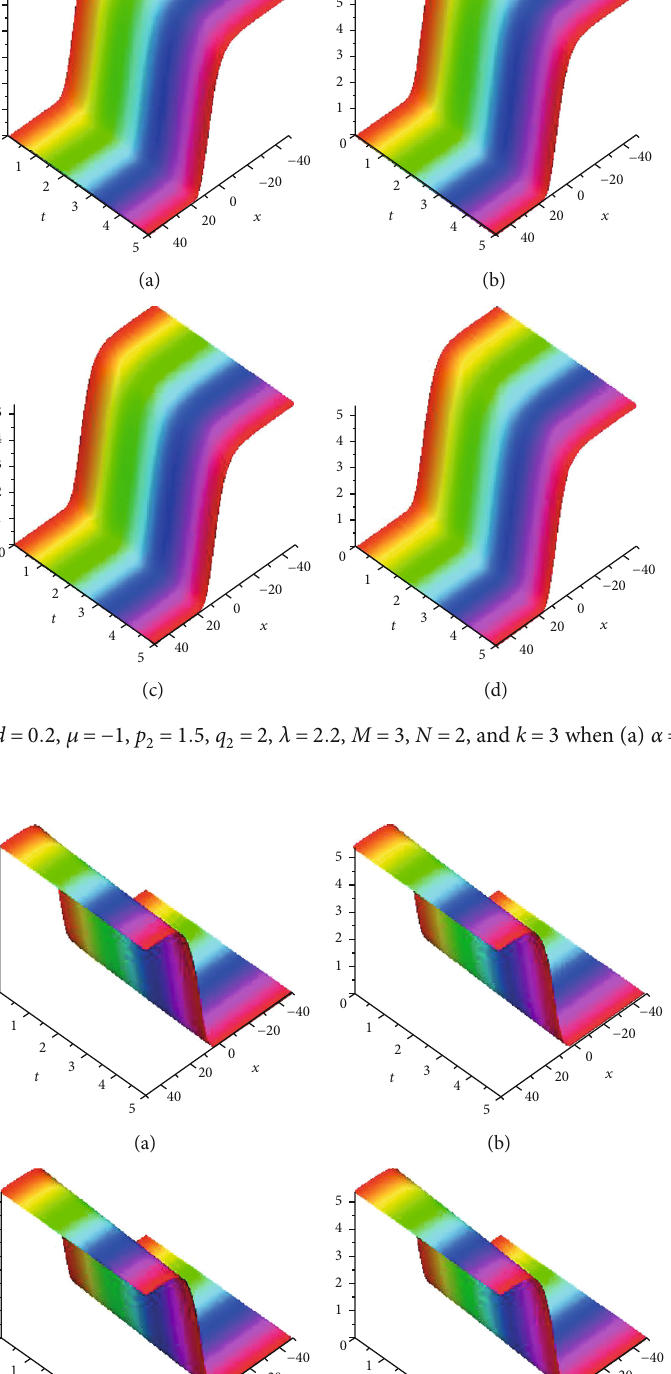
Figure 6: The 3D plot of (80) at d = 0 : 2 , μ = − 1 , r and (d) α = 0 : 99